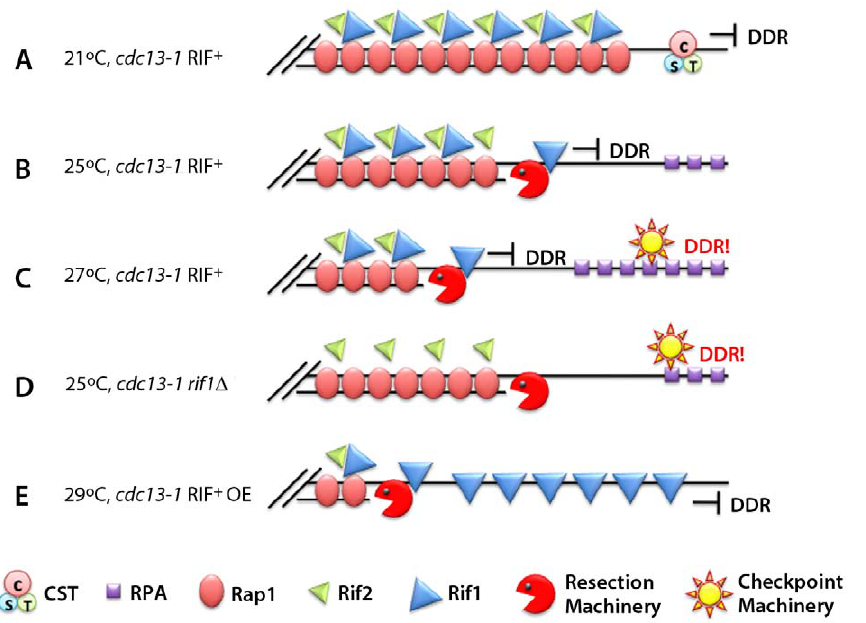
Figure 1. Rif1 works as an anti-checkpoint protein. (A) At 21 u C the CST complex in a cdc13-1 RIF1 + strain is still functional and ‘‘caps’’ the telomeres, preventing the DNA damage response (DDR). (B) At 25 u C the CST is not entirely functional. The resection machinery (Sgs1, Exo1, etc.) creates ssDNA. The presence of Rif1 prevents DDR activation. (C) At 27 u C the CST becomes non-functional, and the amount of Rif1 available cannot prevent binding of RPA and additional checkpoint proteins. (D) In the absence of Rif1, the checkpoint is elicited even at 25 u C. (E) Over-expressing Rif1 allows the cells to grow at 29 u C without eliciting the DDR.